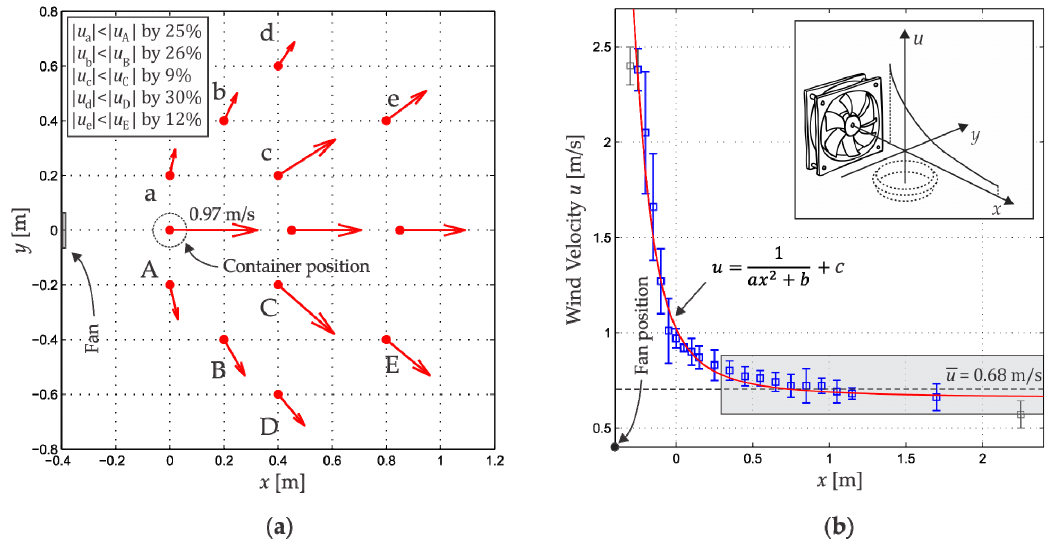
Figure 6. ( a ) Wind velocity distribution in the container vicinity. In the inset are presented the differences between uppercase and lowercase velocity magnitudes; ( b ) Wind velocity distribution along the (cid:1876) ‐ axis.